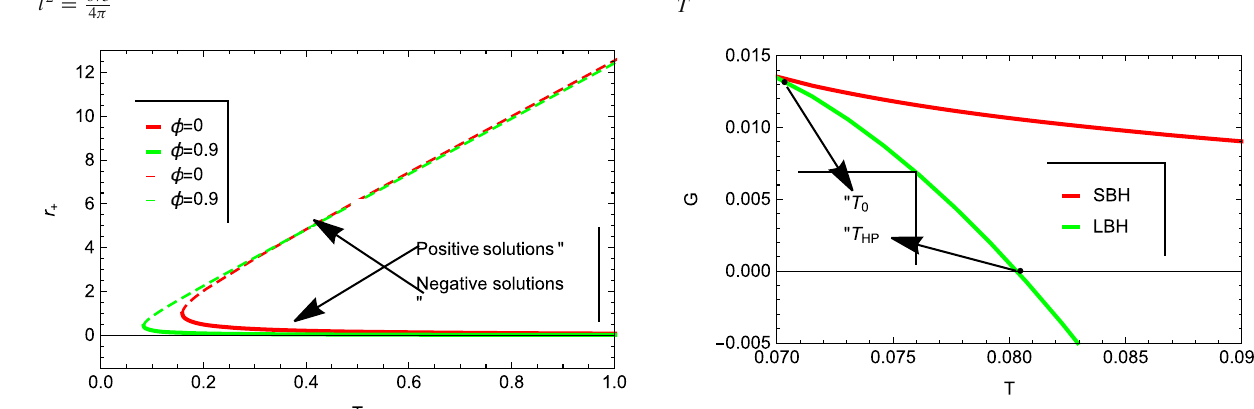
Fig. 8 Plot of the temperature w.r.t deflection angle for b = 10 and